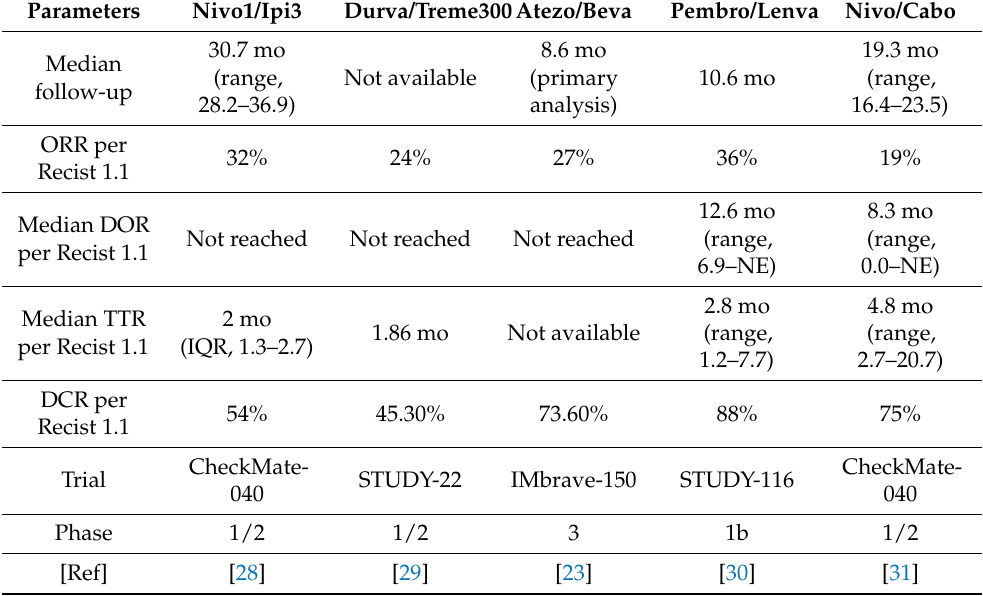
Table 1. Summary of response, disease control, and durability in the immuno-oncology-based combination